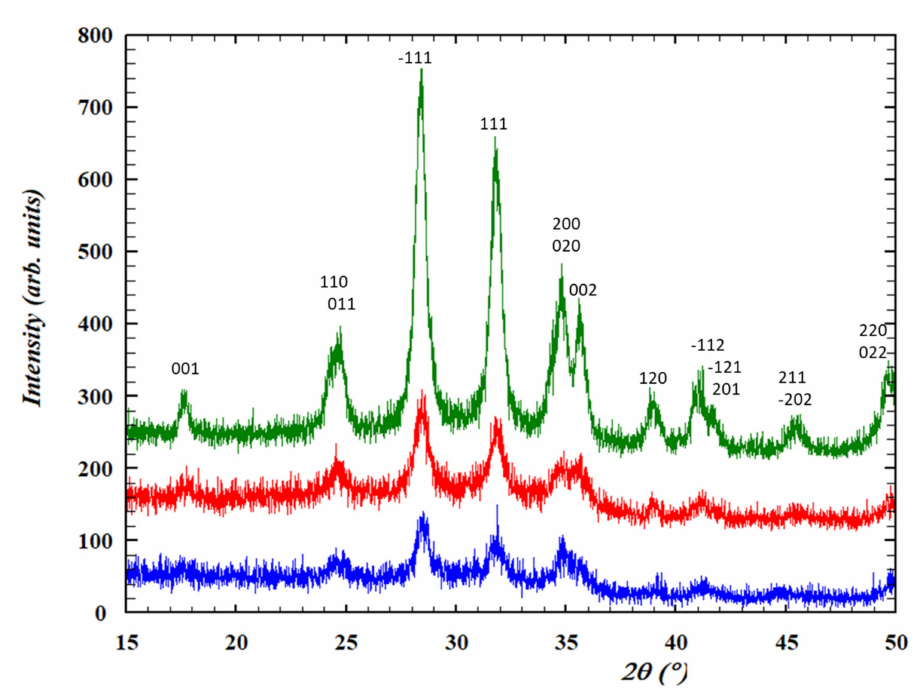
Figure 12. Grazing incidence X-ray diffraction patterns of electrophoretic HfO 2-EPD coatings of (blue) 5 nm, (red) 50 nm, and (green) 100 nm sized particles at incidence angles of 0.2 ◦ from the